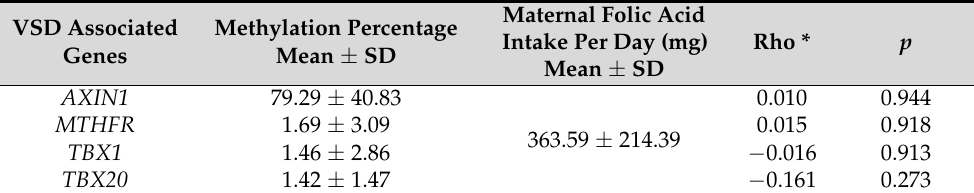
Table 5. Correlation of maternal folic acid dietary intake with the methylation percentage of genes associated with VSD in